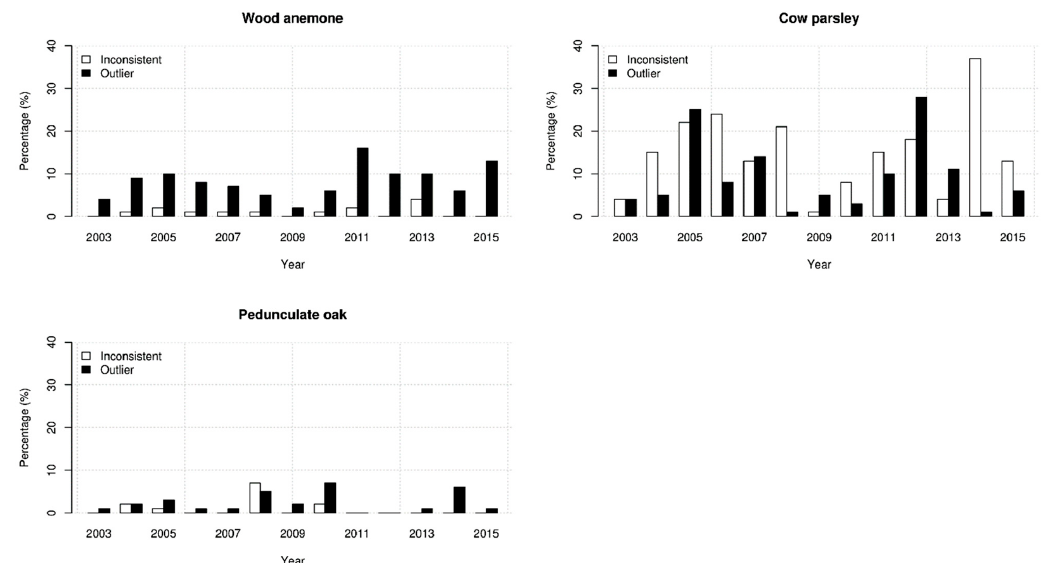
Figure A8. Annual percentages of inconsistent observations and of boxplot outliers in volunteered observations of wood anemone, cow parseley and pedunculate oak. Inconsistent observations are unusually early or late DOYs with respect to the regional temperature regime of the observation sites, while the outliers are only very early or late DOY.